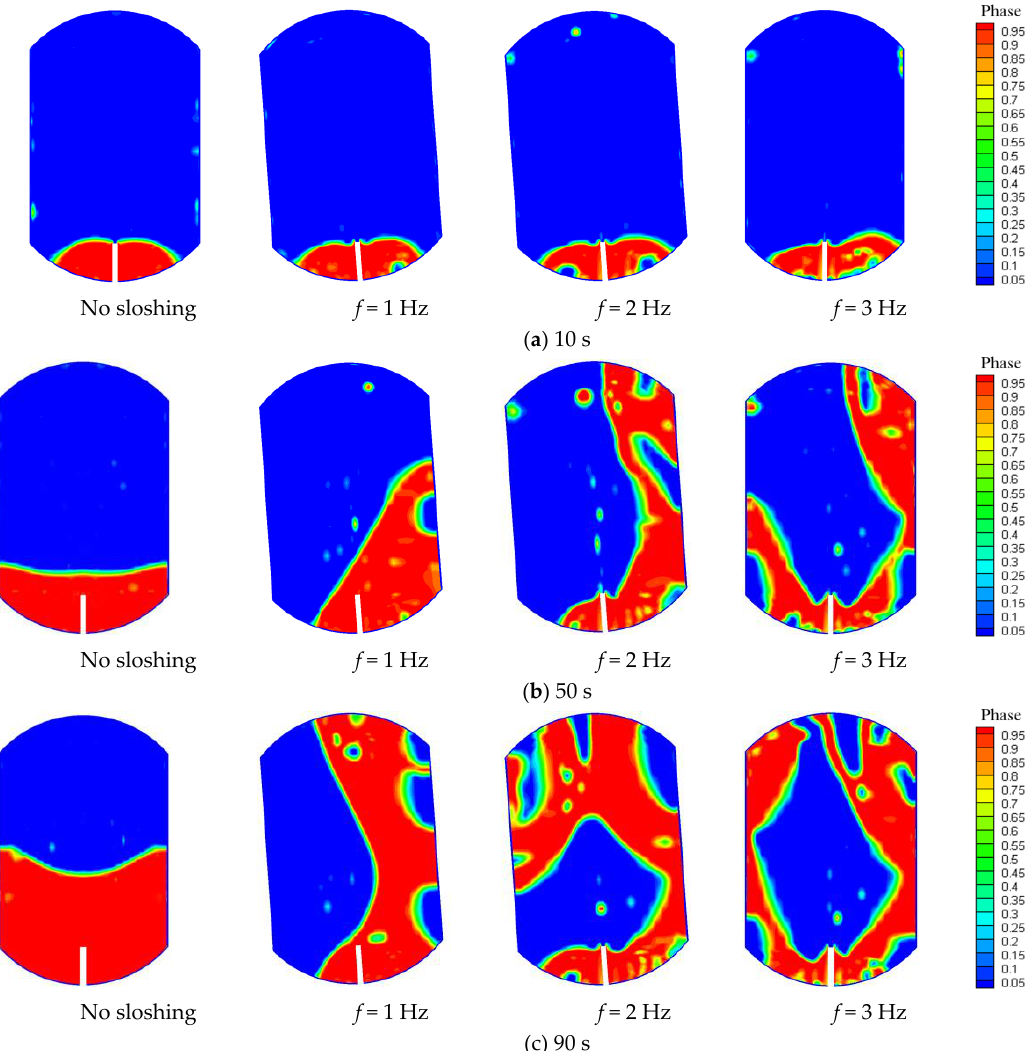
Figure 18. Graphic contours of phase distribution under different sloshing and microgravity conditions at ( a ) 10 s, ( b ) 50 s, and ( c ) 90 s.